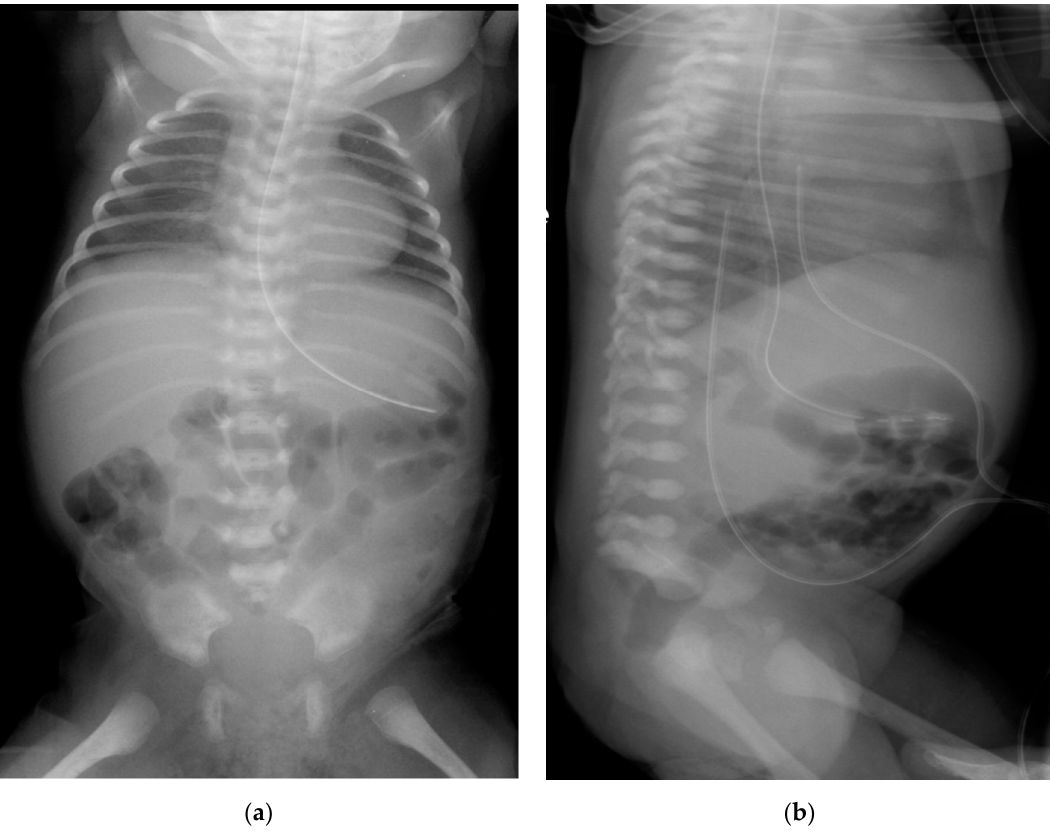
Figure 2. Plain (anteroposterior ( a ) and lateral ( b )) radiograph of chest and abdomen showing absent sacrum. Both the umbilical arterial and venous catheters on the lateral view were not appropriately positioned but was pulled back to optimal site.